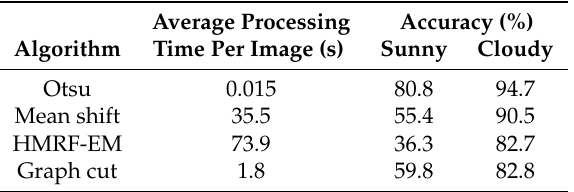
Table 4. The performances of the different sky extraction algorithms (extracted from